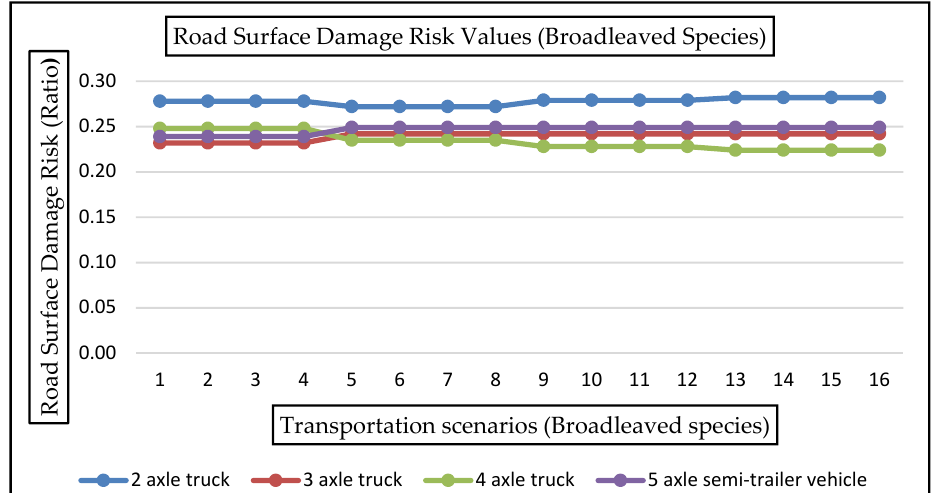
Figure 9. Road surface risk values for coniferous species. Table 20. Road surface risk values in terms of broadleaved species for vehicle alternatives.